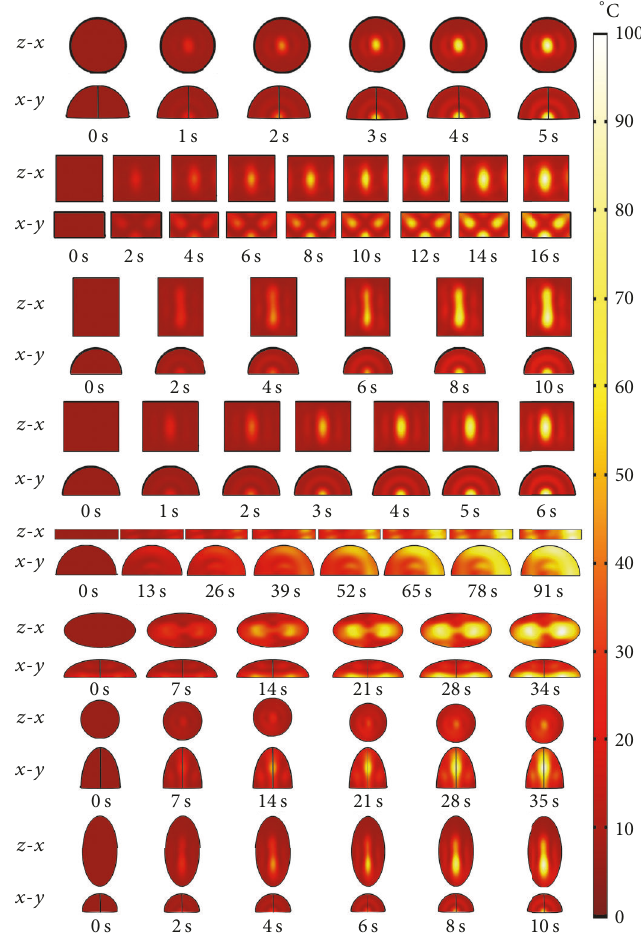
Figure 3: Hot spot in different